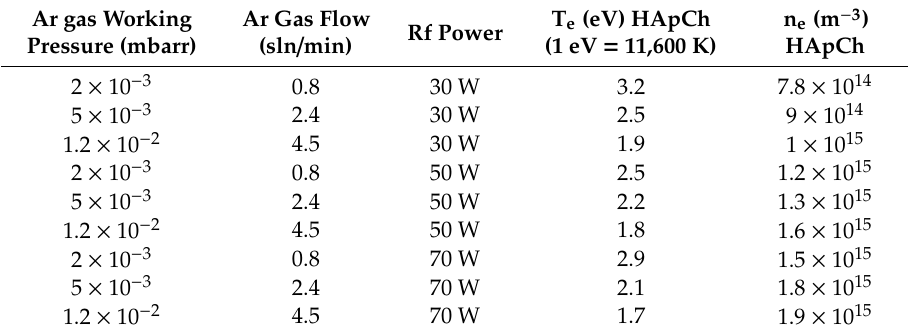
Table 1. Electron temperature and electron number density.